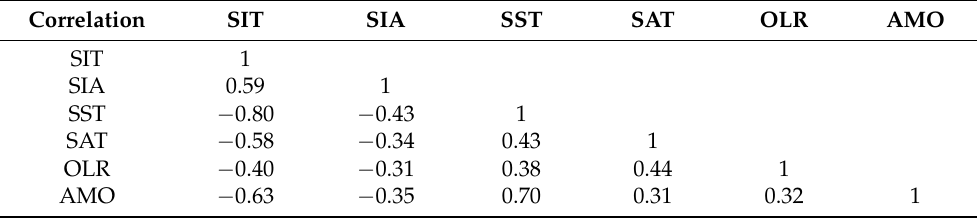
Table 4. Correlation matrix of the monthly anomalies (1979–2020) of SIT, SIA and atmospheric, oceanic parameters for the Atlantic sector (the numbers are statistically significant at a confidence level of